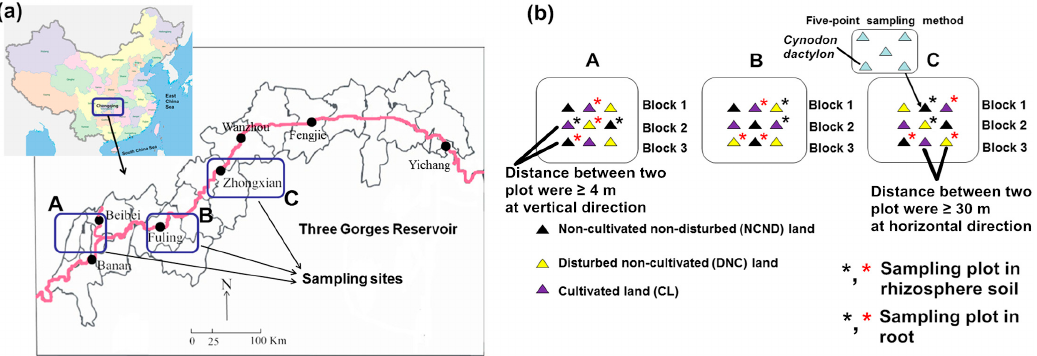
Figure 1. Geographical locations of study sites ( a ) and sampling patterns of both roots and soils in three contrasting land use types ( b ) along the drawdown zone of Three Gorges Reservoir.